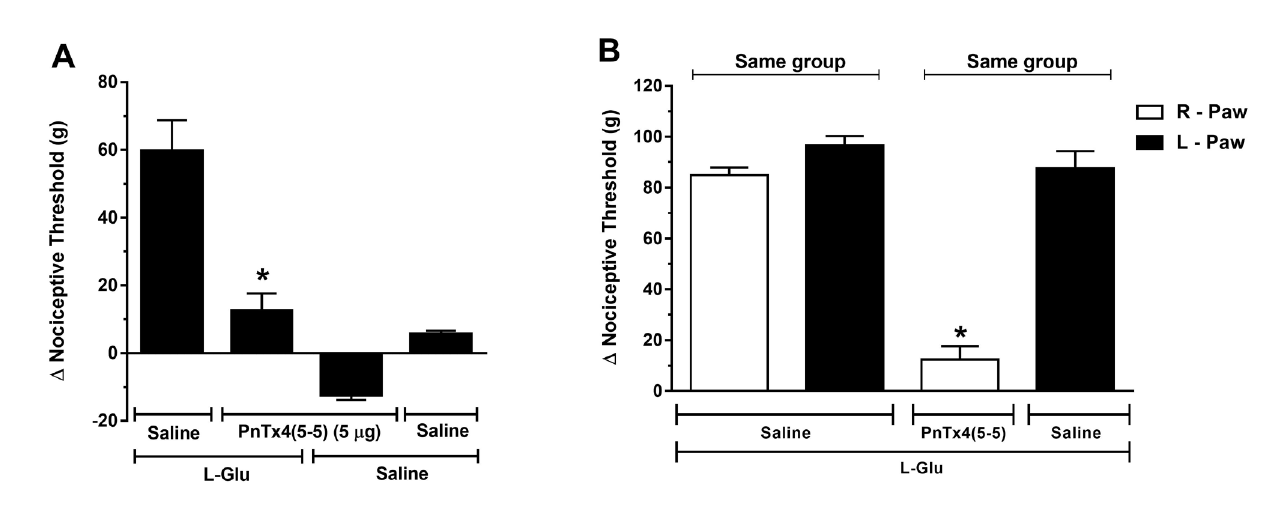
Figure 5. Effect of PnTx4(5-5) on L-Glu induced hyperalgesia. ( A ) Effect of intraplantar administration of PnTx4(5-5) (5 µg) on hyperalgesia induced by L-Glu (1 µg/paw). PnTx4(5-5) was administered 5 minutes after L-Glu. ( B ) Exclusion of systemic antinociceptive effect of PnTx4(5-5) at a dose of 5 µg. Toxin or saline were injected into the right paw (RP) 5 minutes after administration of L-Glu (1 µg) in both hind paws (RP/LP). Each column represents the mean ± S.E.M. of Δ nociceptive threshold (g) for four animals. *Indicates statistical significant difference (p < 0.05) from the control group (L-Glu + saline -